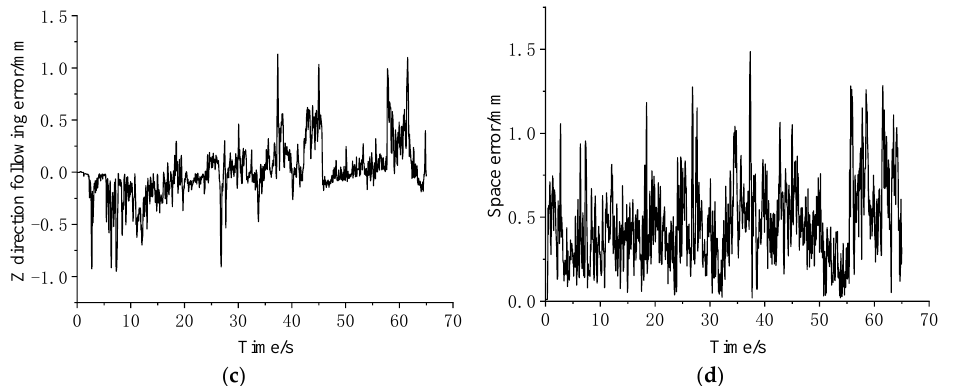
Figure 17. Master – slave following error in gripping and handling experiments. ( a ) X direction. ( b ) Y direction. ( c ) Z direction. ( d ) Resultant.